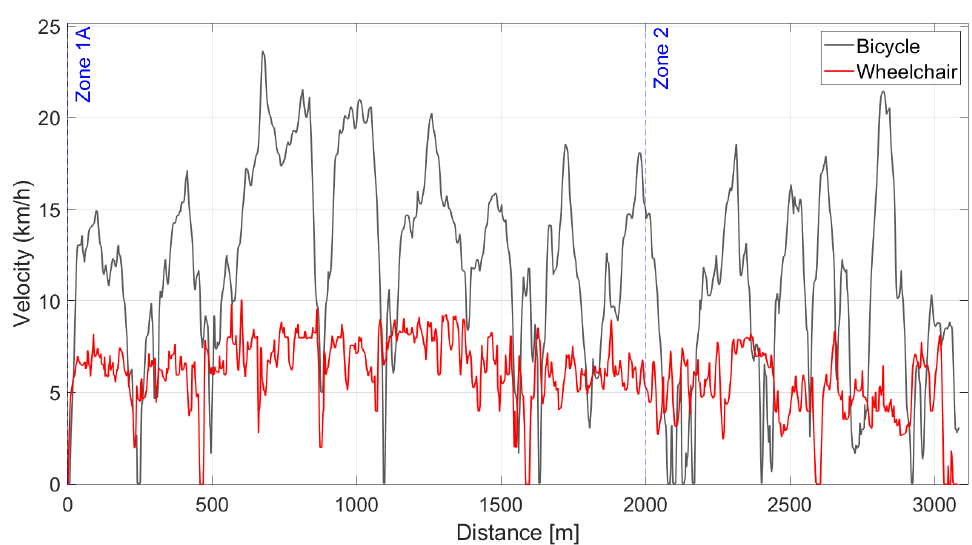
Figure 6. Comparison between the speed profiles of a wheelchair and a